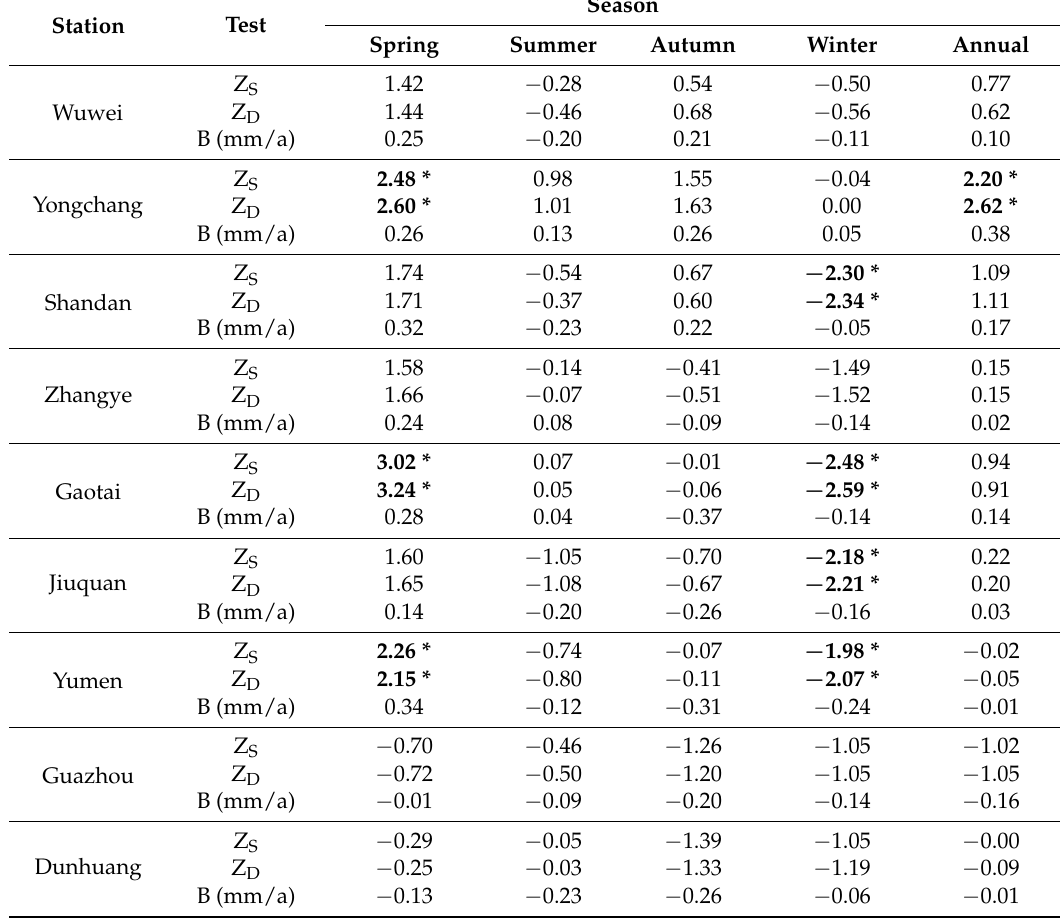
Table 8. Statistical tests for seasonal and annual precipitation data during